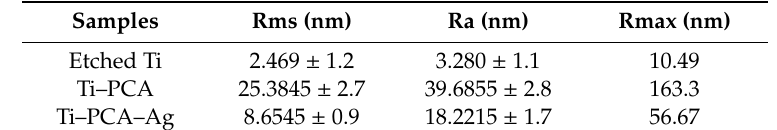
Table 1. Atomic force microscopy (AFM) analysis survey of the surface roughness of different modified titanium samples.